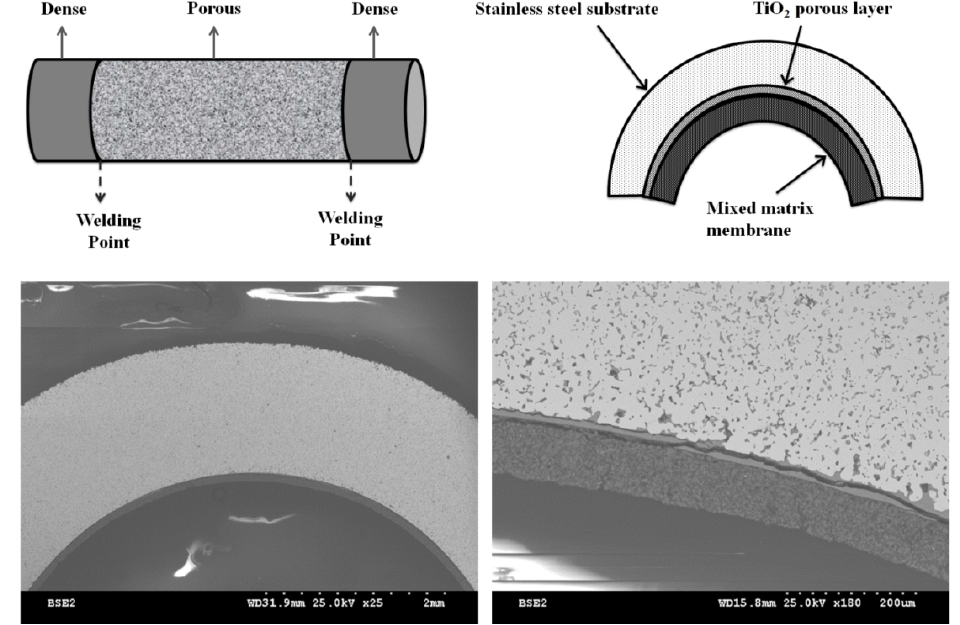
Figure 6. Schematic picture of side and cross-section of the tubular zeolite membrane and SEM cross-sectional images.